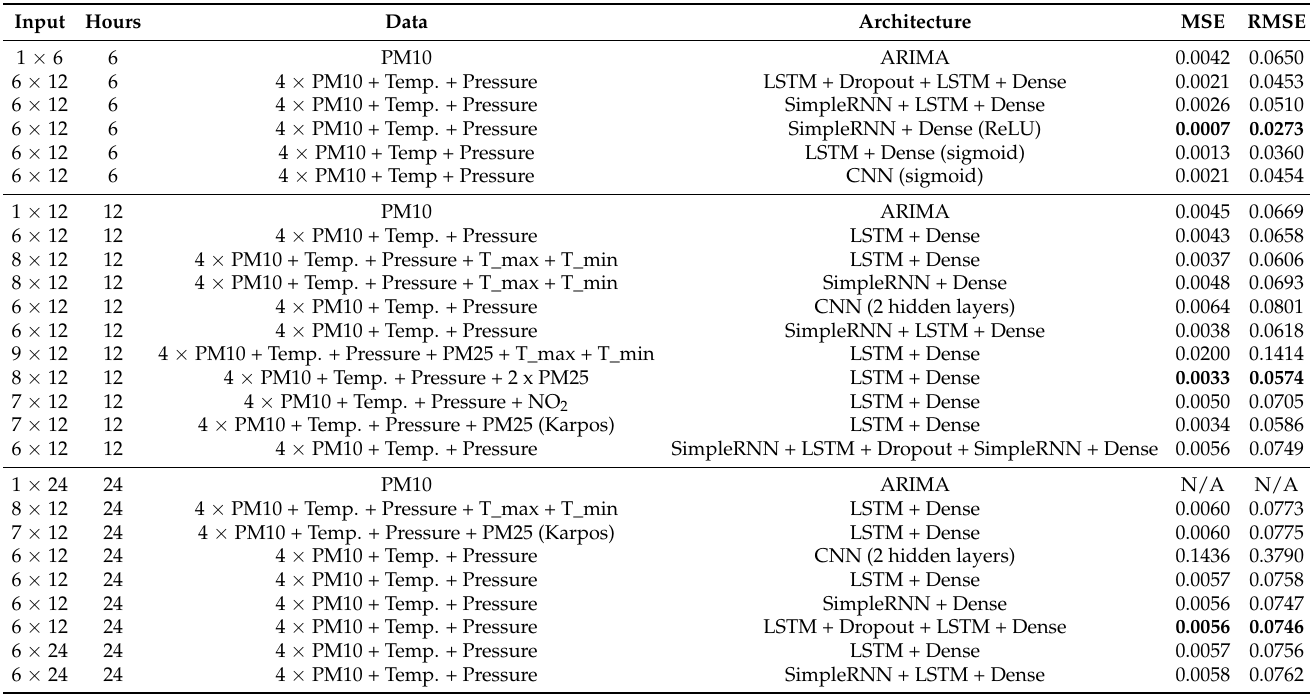
Table 7. Summary of the evaluated approaches with the achieved average forecasting performance in terms of Mean Squared Error (MSE) and Root Mean Squared Error (RMSE) for the 6, 12, and 24 h time horizons for the test dataset in the period from 1 February 2019 to 1 February 2020. The best performance for each time horizon is marked in